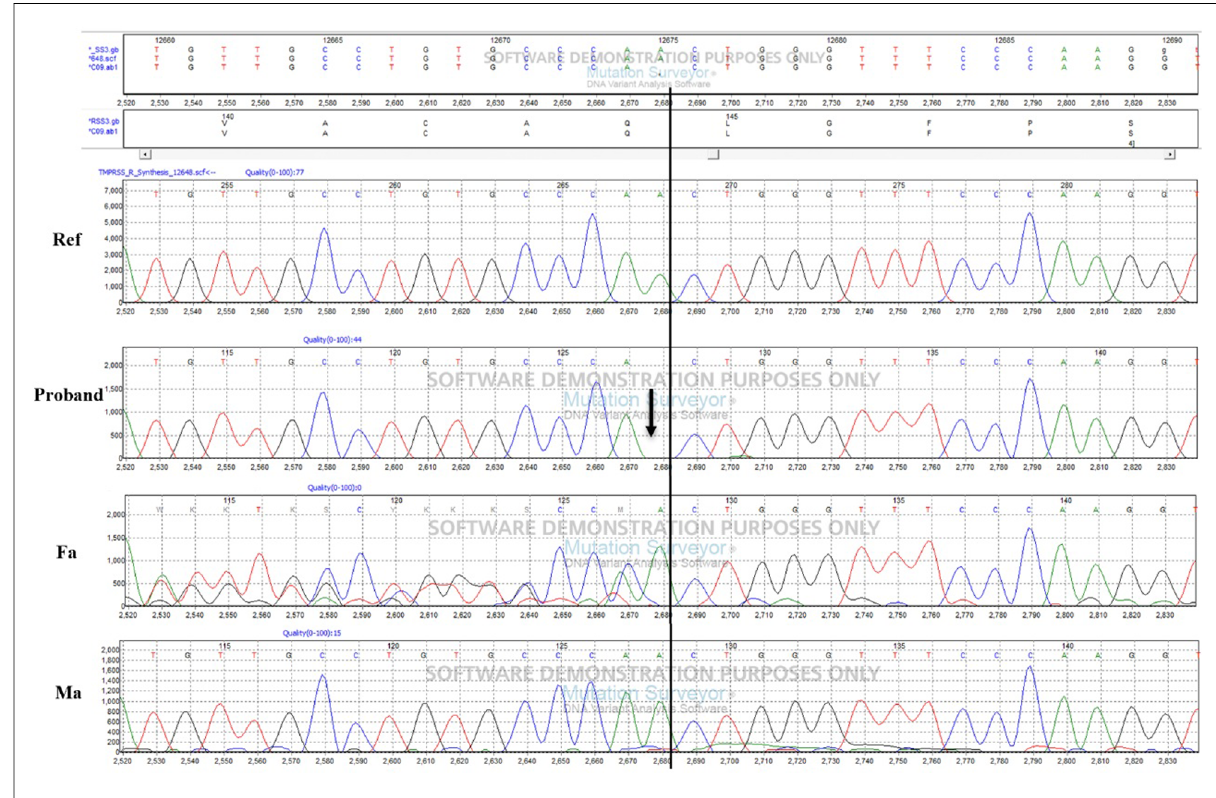
FIGURE 3 Validation of the frameshift mutation in TMPRSS3 by sanger